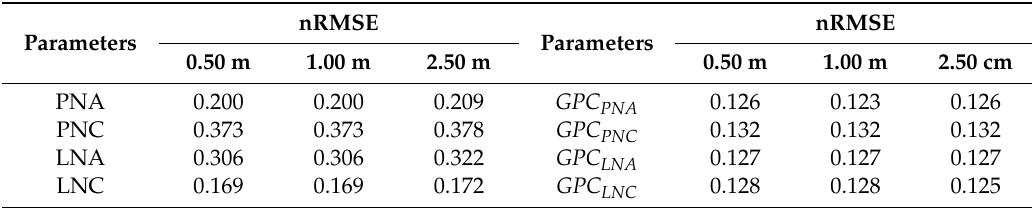
Table 11. Normalized root mean square error (nRMSE) of four nitrogen nutrition parameter models based on the di ff erent spatial resolution UAV images.